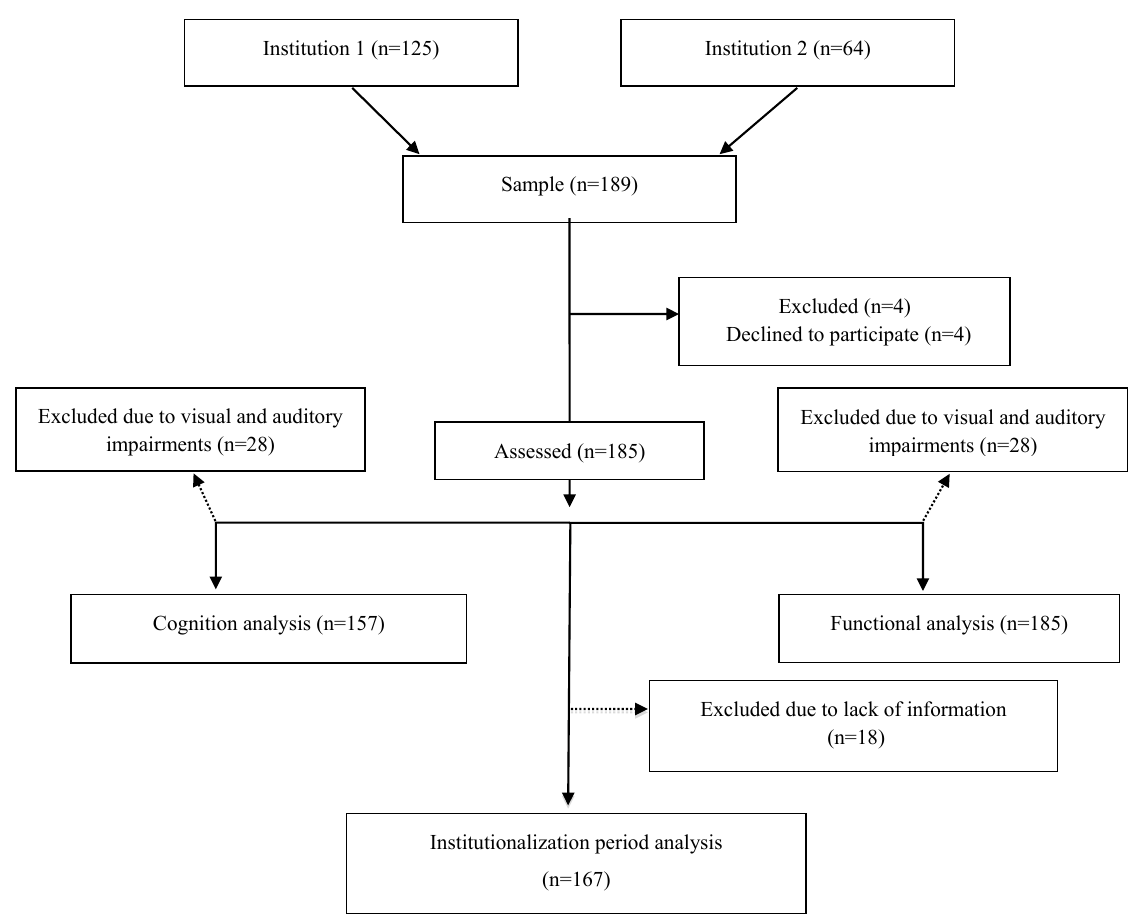
Figure 1. Flowchart displaying the recruitment of